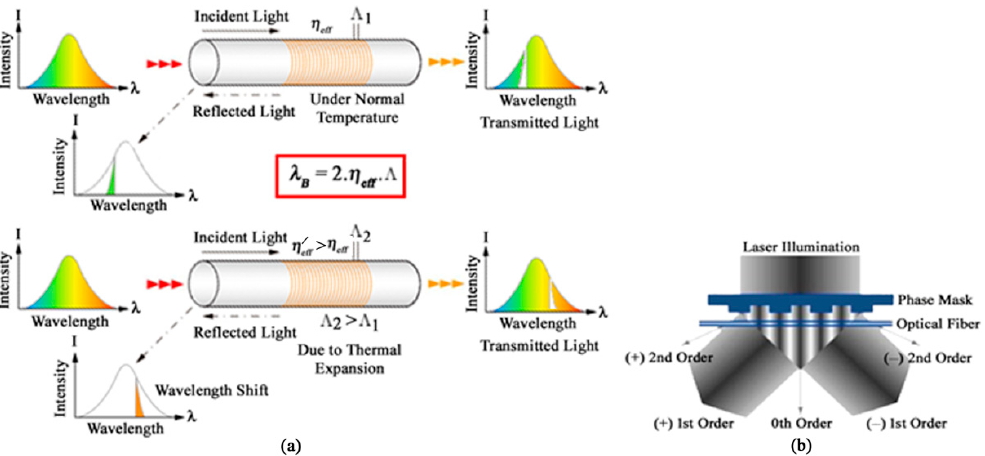
Figure 1. Basic principles of ( a ) FBG sensors for the measurement of temperature sensitivity; ( b ) the laser-assisted phase mask technique for fabricating FBG